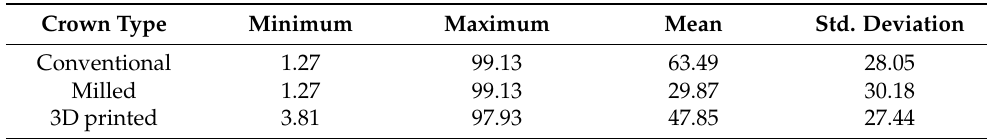
Table 1. Mean marginal gap of crowns fabricated through conventional, milled and 3D printed wax patterns ( µ